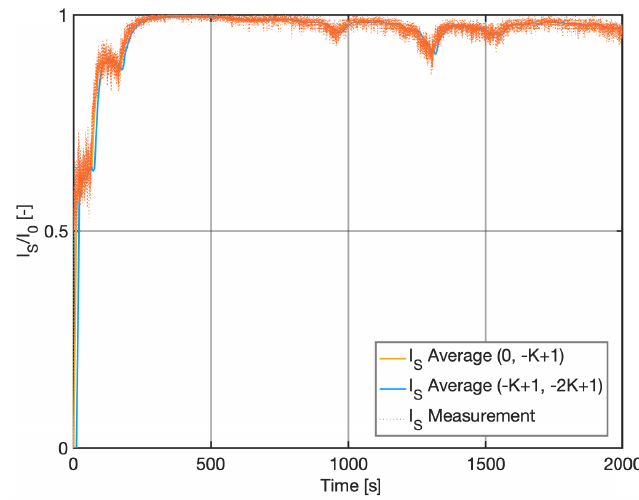
Figure 7. Effect of measurement noise on the determination